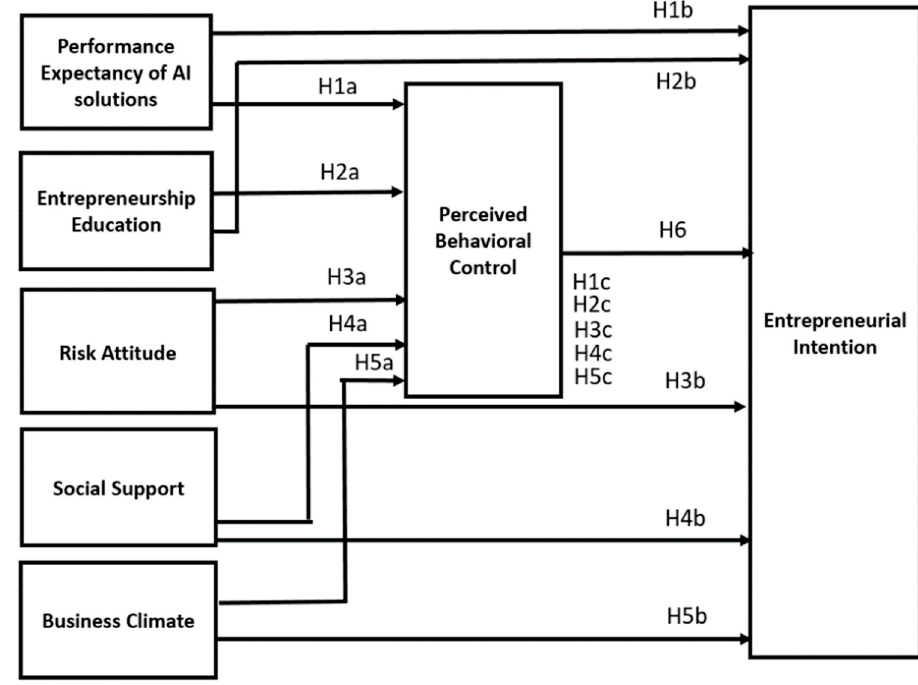
Figure 1. Proposed conceptual framework.